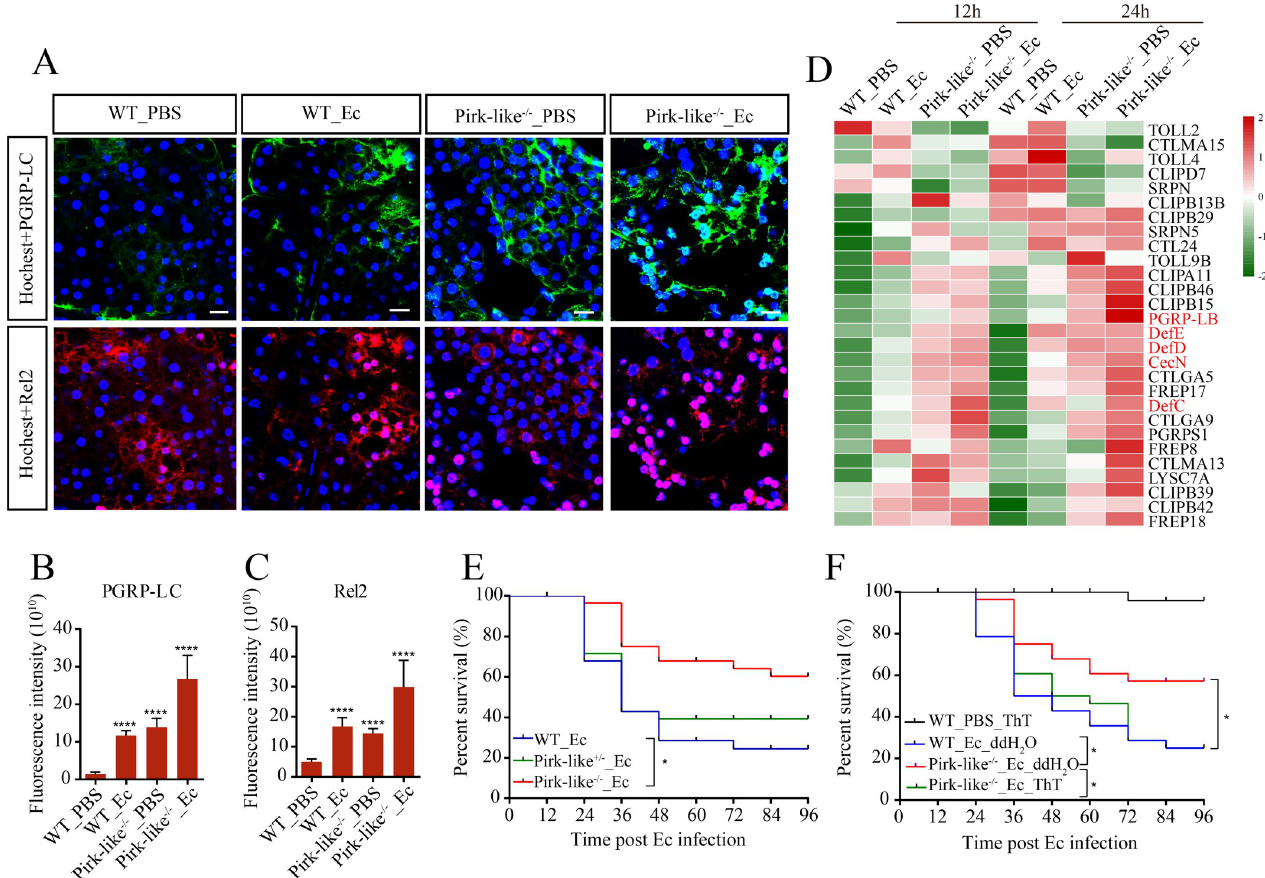
Fig 6. Pirk-like acts as an essential negative regulator of the IMD pathway. (A) Immunostaining of WT and Pirk-like -/- mosquito fat bodies that were stimulated with PBS or E . cloacae at 12 h PBM and then dissected to measure PGRP-LC and Rel2 expressions at 24 h post infection. Scale bar: 20 μ m. (B and C) Quantification of relative fluorescence intensity of cells shown in (A). Quantification showing mean ± SEM from three independent experiments. (D) Heatmap of the 28 shared IMRGs. They show the highest abundance among bacteria-infected Pirk-like -/- mosquitoes (Pirk-like -/- _Ec) and the lowest among bacteria- infected WT mosquitoes (WT_Ec), with an intermediate level of abundance in non-infected Pirk-like -/- mosquitoes (Pirk-like -/- _PBS). Non-infected WT mosquitoes (WT_PBS) were used as control. (E) Survival rate of Pirk-like -/- , Pirk-like +/- and WT female mosquitoes after E . cloacae infection. n = 3 cohorts (total 90 mosquitoes). (F) Survival rate of Pirk-like -/- and WT female mosquitoes after infection. Mosquitoes were fed with 1 mM ThT during the PBM phase. n = 3 cohorts (total 90 mosquitoes).